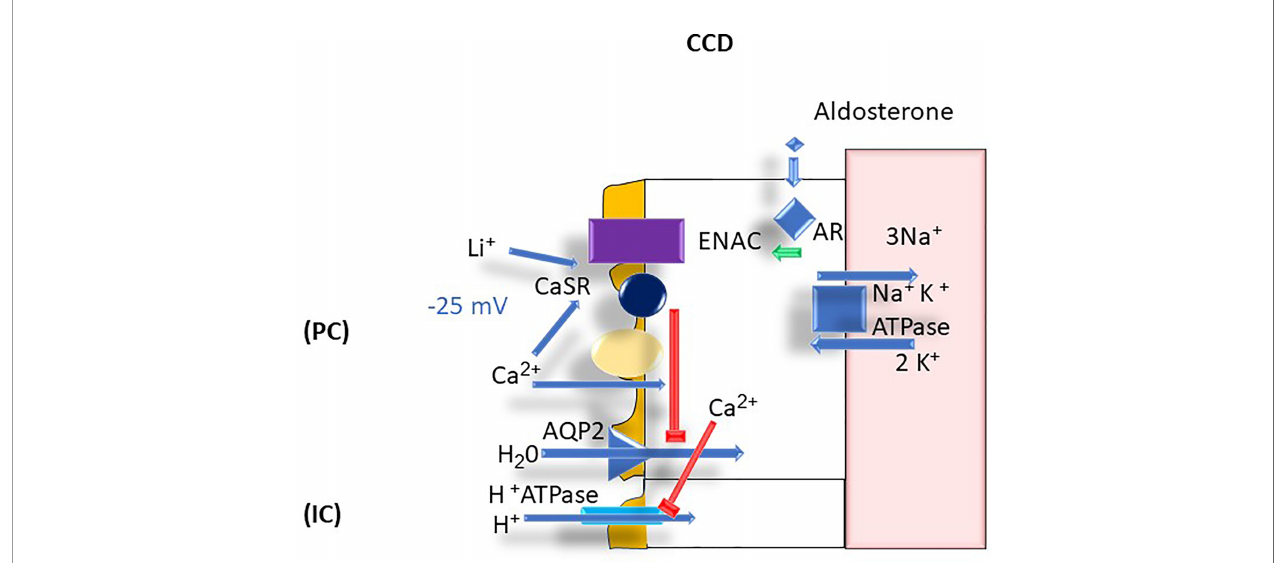
FIGURE 7 | CCDCa 2+ transport: AR, aldosterone receptor;AQP2, aquaporin 2; ATPase, adenosine triphosphatase; Ca 2+ , calcium;CaSR,calcium sensing receptor; CCD, cortical collecting duct, ENaC, epithelialsodiumchannel; H + , proton; H 2 O, water;IC, intercalatedcells; K + , potassium; Li + ; lithium; mV, millivolt; Na + ; sodium; PC, principal